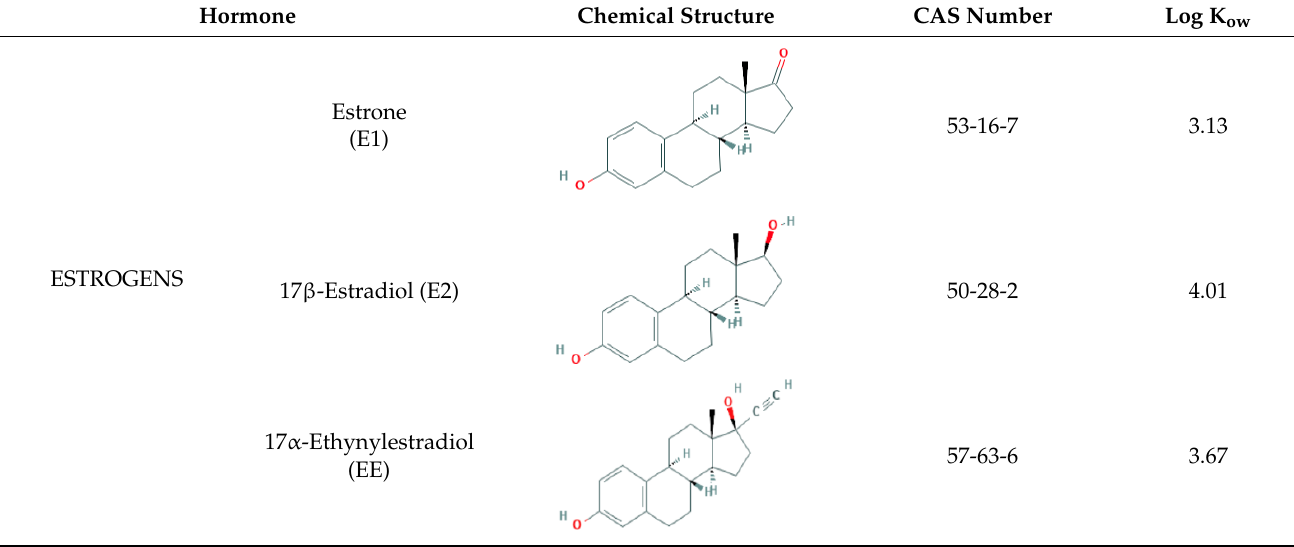
Table 1. List of target hormones studied and their acronyms, chemical structures, CAS numbers, and log K OW values. Data were extracted from the PubChem database.